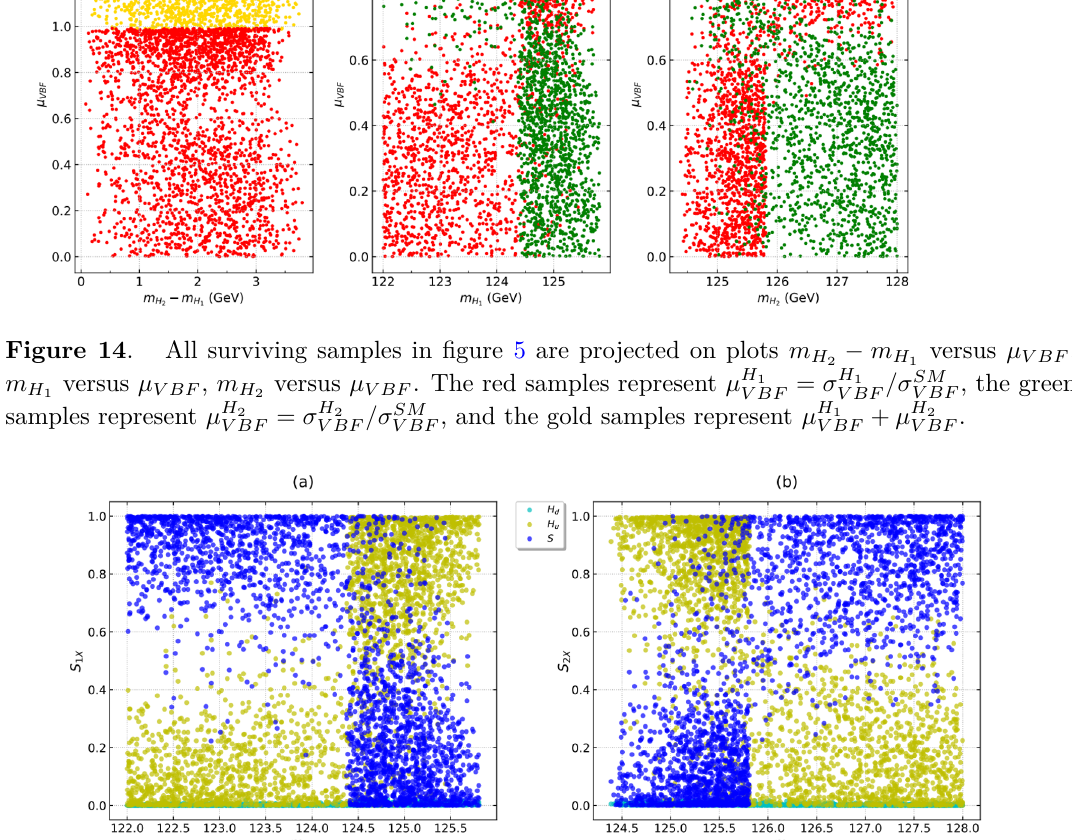
- S and m - 1 X H 2 1 ( i = 1 , 2) , the i 1 i 3